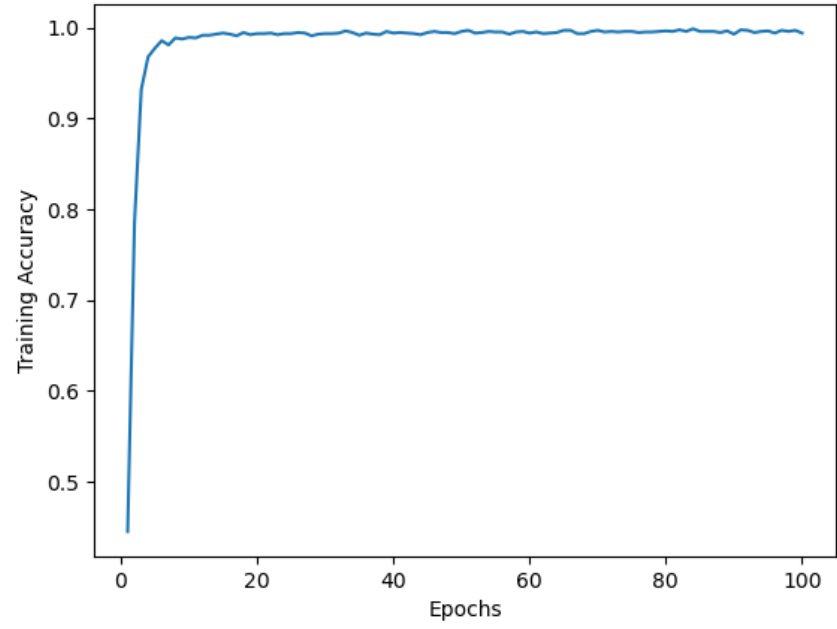
Figure 9. Final training accuracy of the deep learning